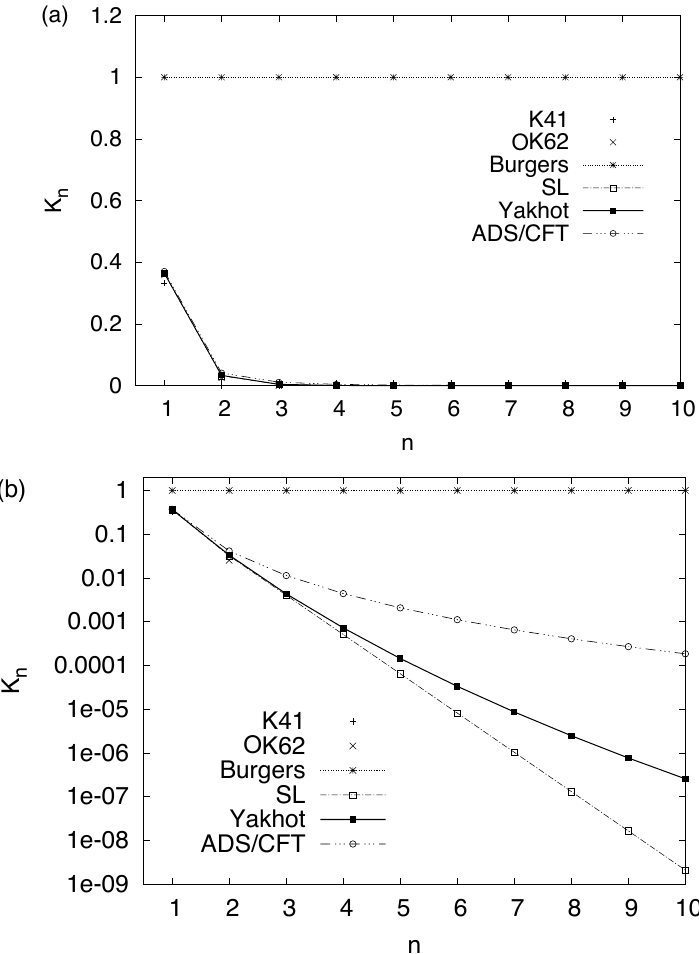
Figure 2. ( a ) reduced Kramers–Moyal coefficients from Equation (17) for different phenomenological models of turbulence up to the order n = 10. Coefficients for n > 2 seem to tend towards zero; ( b ) semi-logarithmic plot of the reduced Kramers–Moyal coefficients. All phenomenological models except for K41 and OK62 show an asymptotic behavior. Note that the She–Leveque model possesses a nearly linear slope in the semi-logarithmic